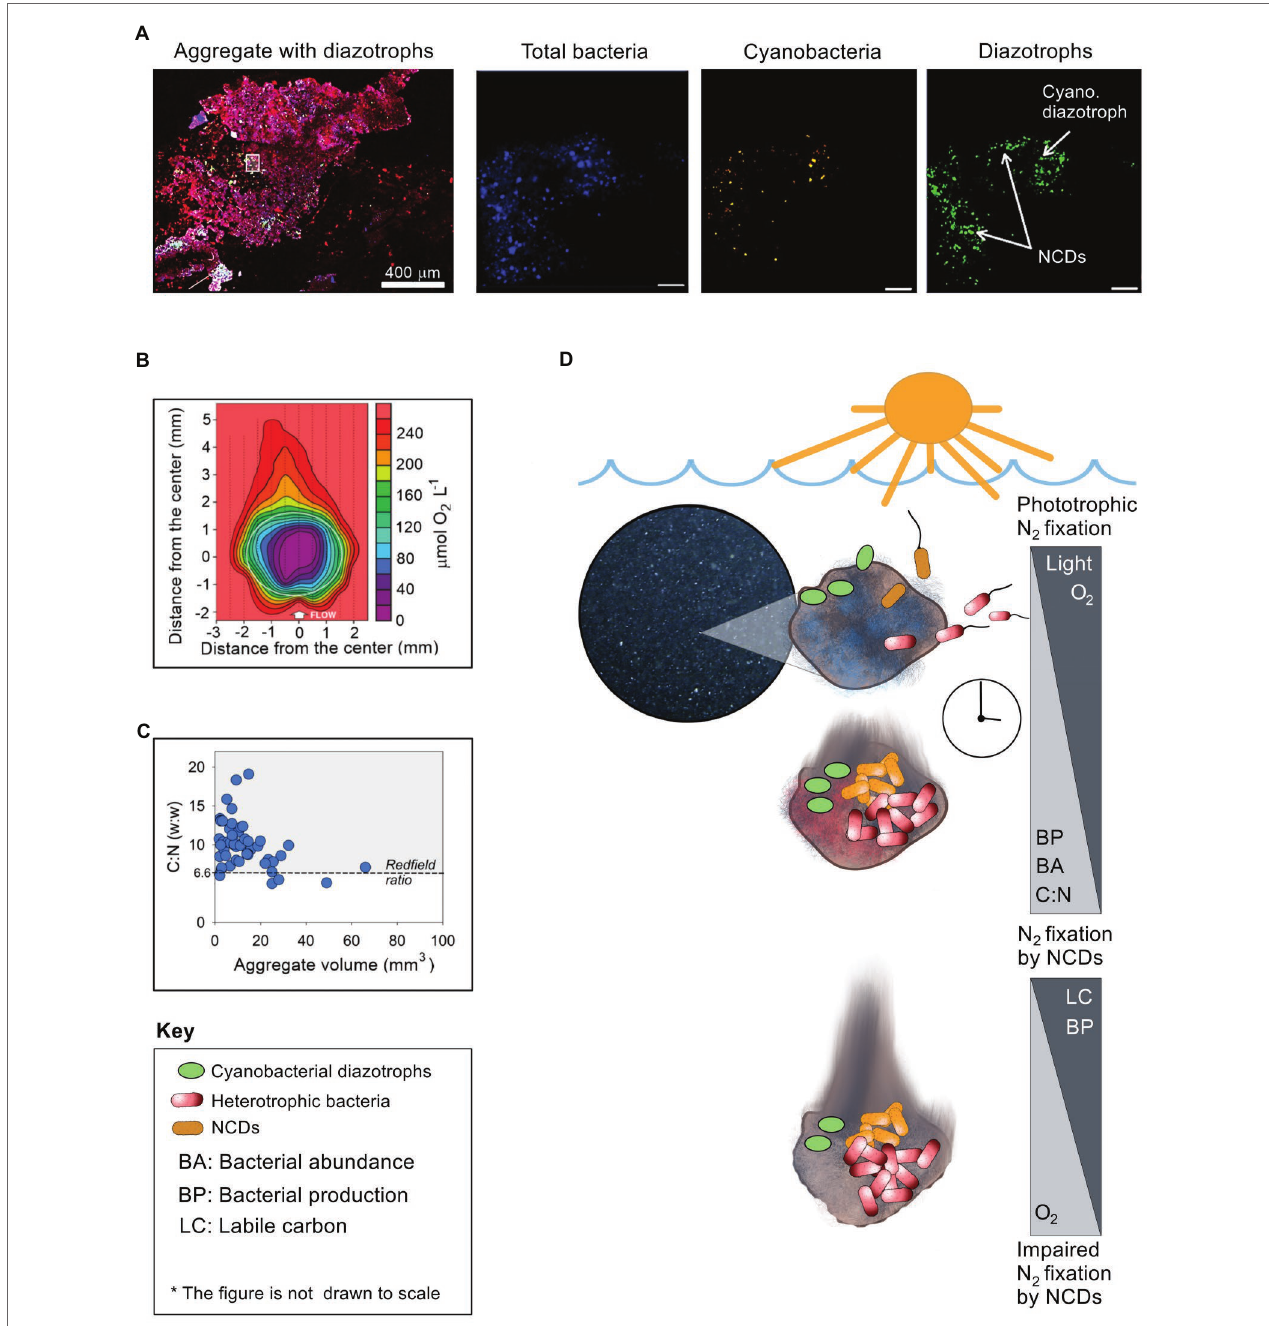
FIGURE 1 | The association of NCDs with planktonic aggregates. (A) Enlarged confocal images of diazotrophs associated with aggregates after staining (red) the polysaccharide matrix by concanavalin A (Geisler et al., 2022). Enlarged images within the aggregate were captured to differentiate between three distinct channels (from left to right): total bacteria (stained by DAPI, blue); total cyanobacteria by autofluorescence of the phycoerythrin pigment (orange/white), and diazotrophs by immunolabeling nitrogenase enzyme. The white square on the aggregate shows the magnified location (scale bar of 10 μ m). (B) Micro-sensor image showing the oxygen levels within a large (> 0.5 mm) planktonic aggregate (Klawonn et al., 2015). (C) Carbon to nitrogen ratio relative to aggregate size (Alldredge and Silver, 1988; Grossart and Ploug, 2001). (D) Conceptual figure illustrating time-course changes in conditions on an aggregate as it sinks in the water column, of key relevance for N 2 fixation by associated NCDs. See text for